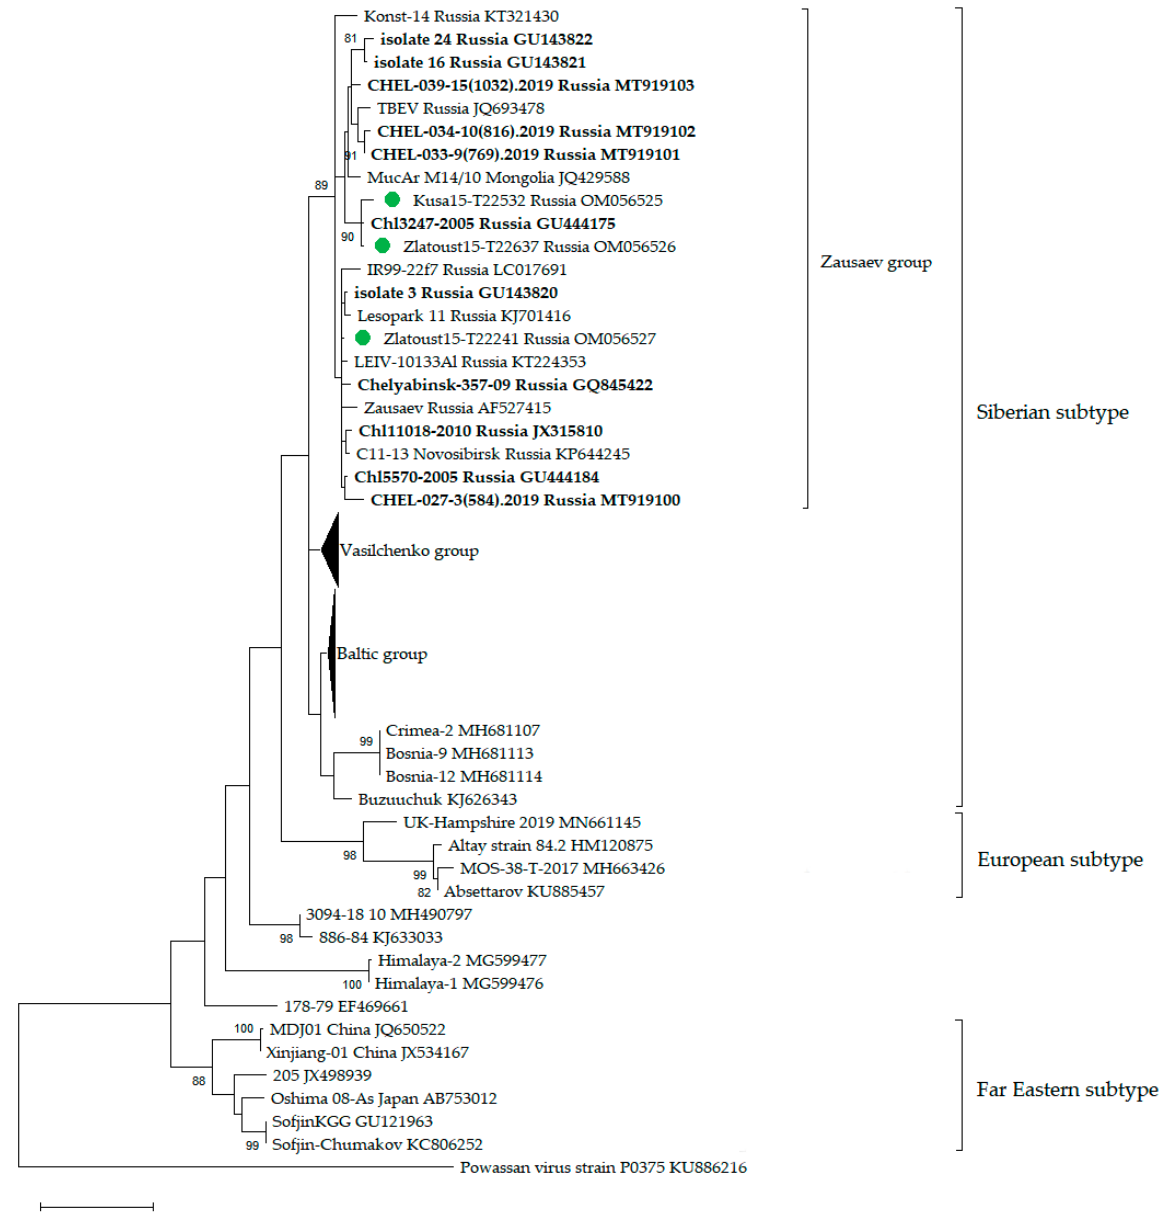
Figure 2. Phylogenetic analysis of the tick-borne encephalitis virus. Phylogenetic trees were con- structed using E protein fragments (352 bp) in MEGA X with the maximum likelihood method (1000 bootstrap replications). Bootstrap values (>70%) are shown at the branches. GenBank ac- cession numbers are listed for each strain. Green circles—strains of TBEV described in this study. All other TBEV strains from the Chelyabinsk region are in bold font.